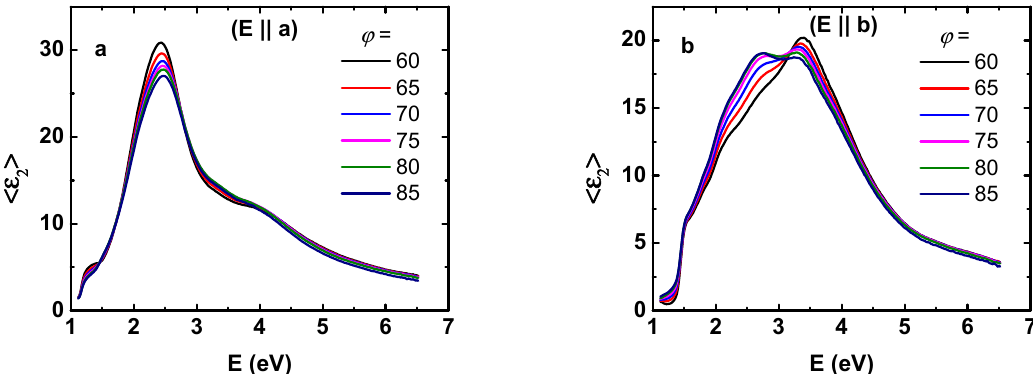
Figure 3. Imaginary parts of the pseudodielectric functions of SnS 0.52 Se 0.48 with several values of AOI from 60° to 85° along ( a ) zigzag and ( b ) armchair directions.